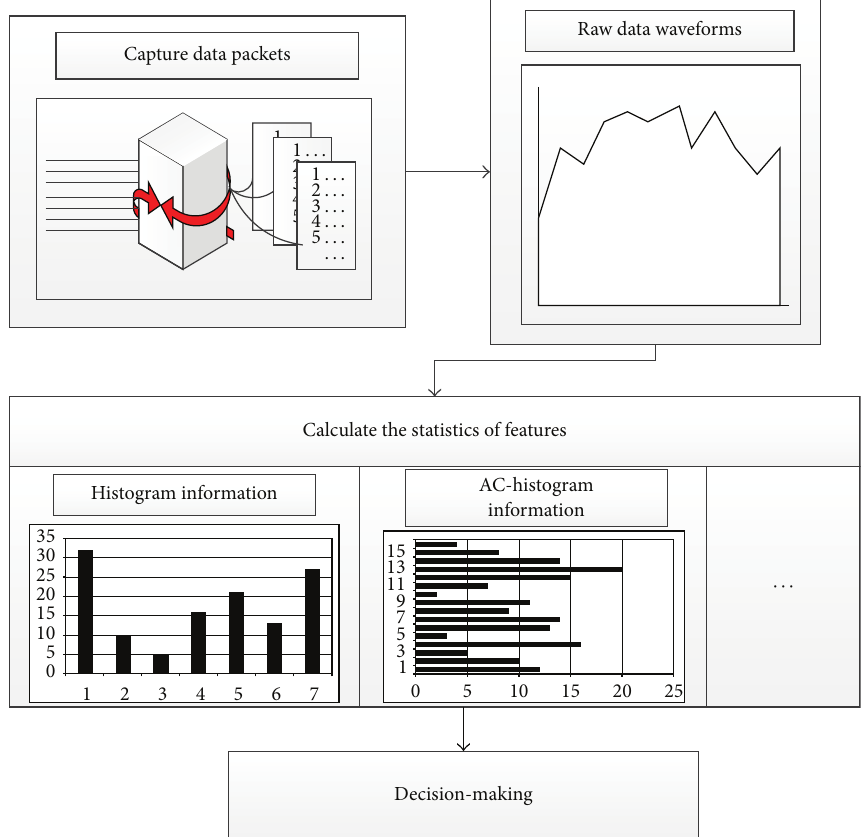
Figure 3: Implementation of matching